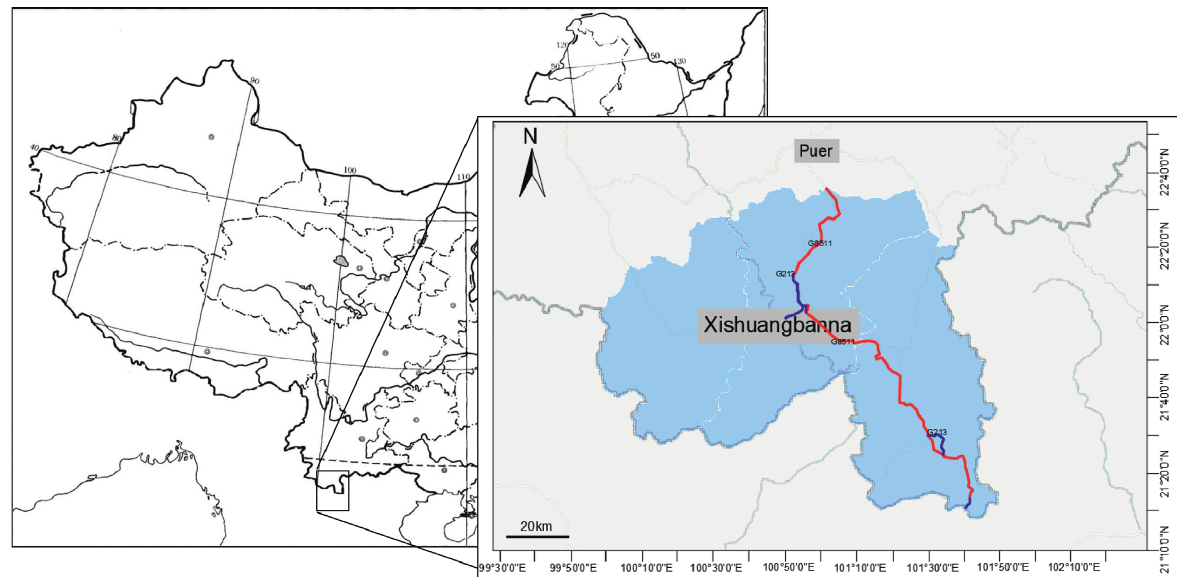
Figure 2: Site location of the XiaoMo highway.